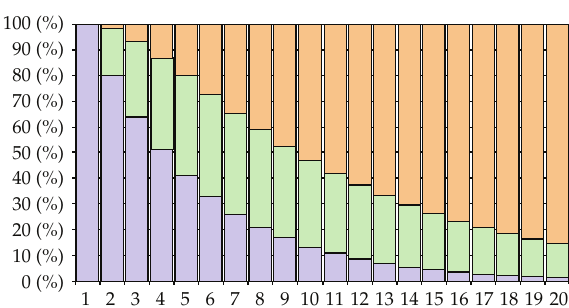
Figure 1: Percentage of individuals at each expectation’s group, for di ff erent attentiveness